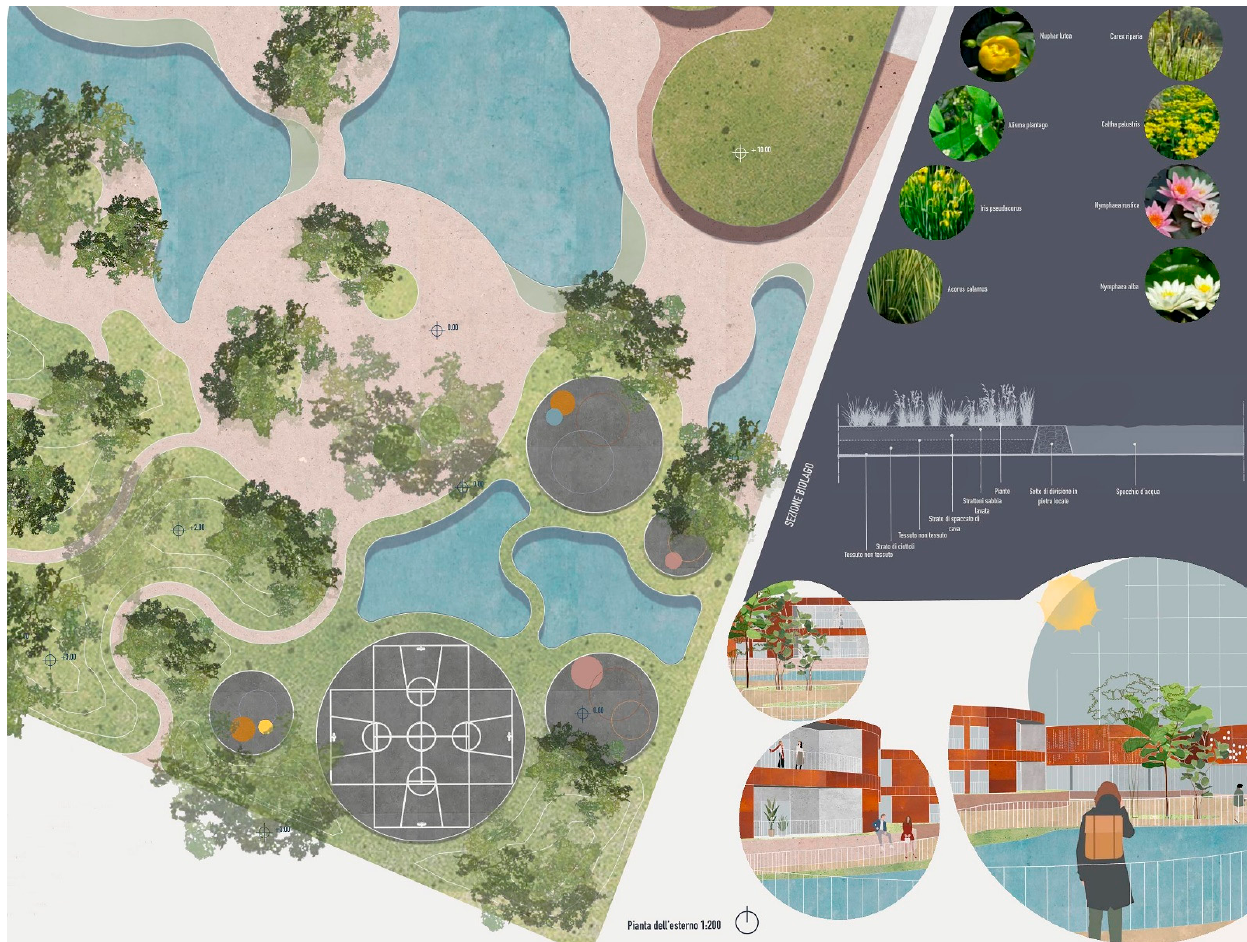
Figure 9. Rome Municipality X, Urban and Metropolitan Centrality Acilia–Madonnetta. Urban project. Bio ‐ lake. (Source: elaborations by the students: S. Maiorano, F. J. Moran, A. Musto, C. Paloni, Urban Planning Laboratory of the Faculty of Architecture of Rome A.A. 2021–2022).